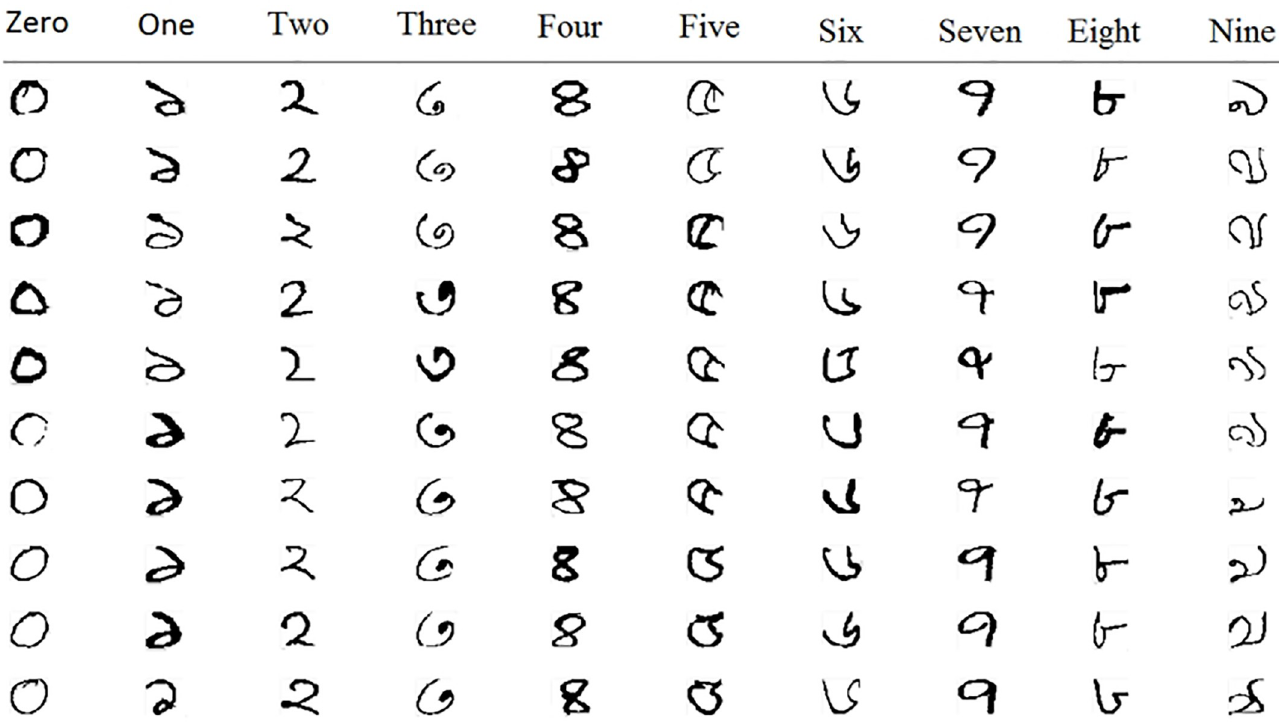
Fig 4. Some sample images from the CMATERdb 3.1.1 database [25].